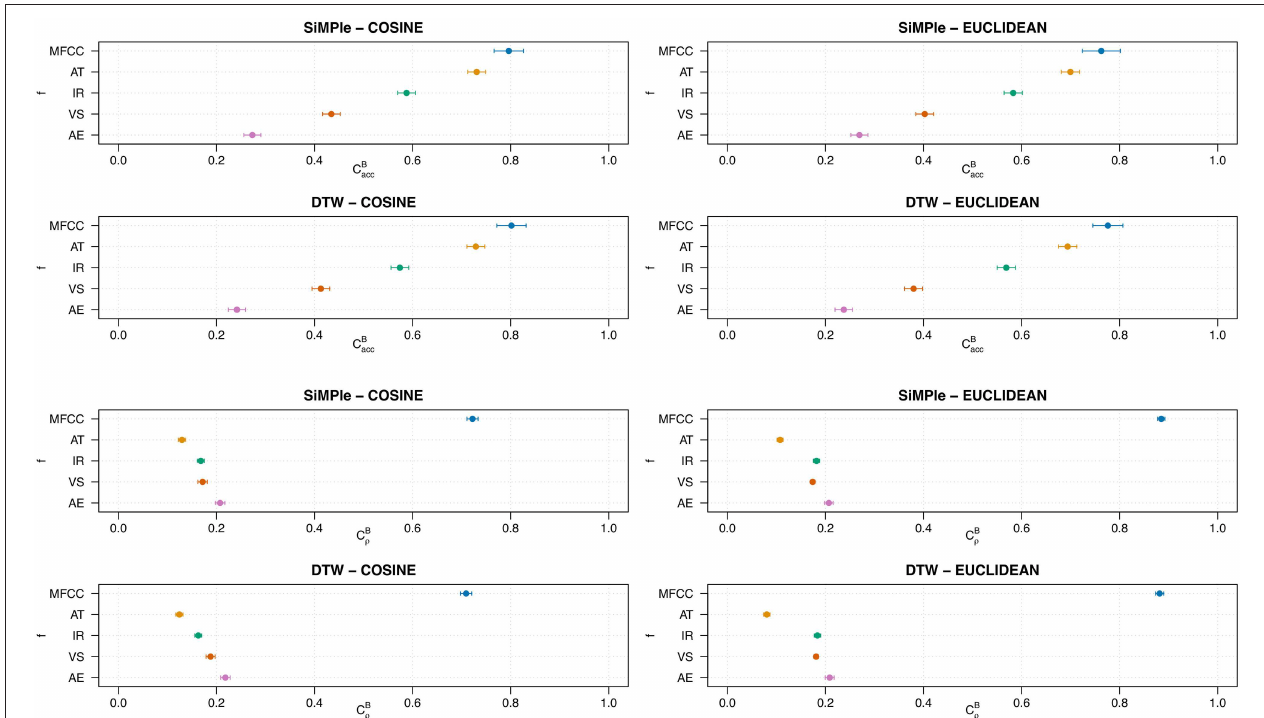
FIGURE 11 | Estimated marginal means for between-space consistency by encoder f . The first and second rows are for C B acc and the third and fourth rows are for C B ρ . Confidence intervals are at the 95% level.